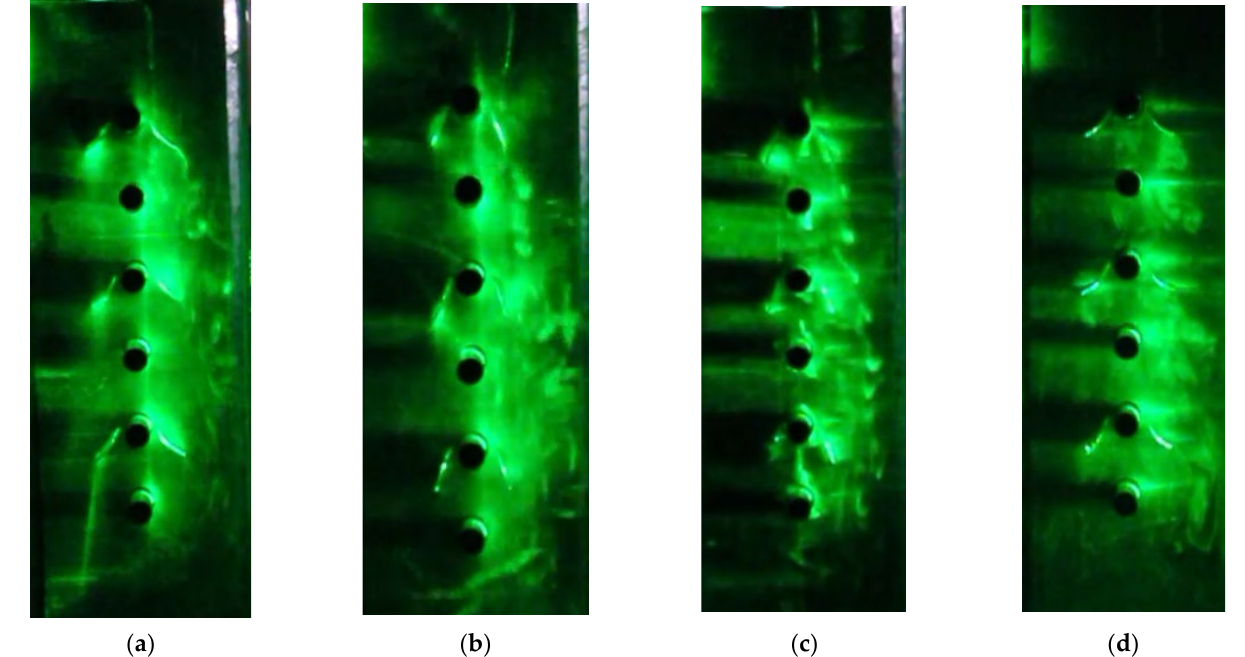
Figure 9. Flow structure in the unidirectional plane for installation: ( a ) CDWP, ( b ) DWP, ( c ) PDWP, and ( d ) PCDWP VG at the flow velocity of 1 m/s.